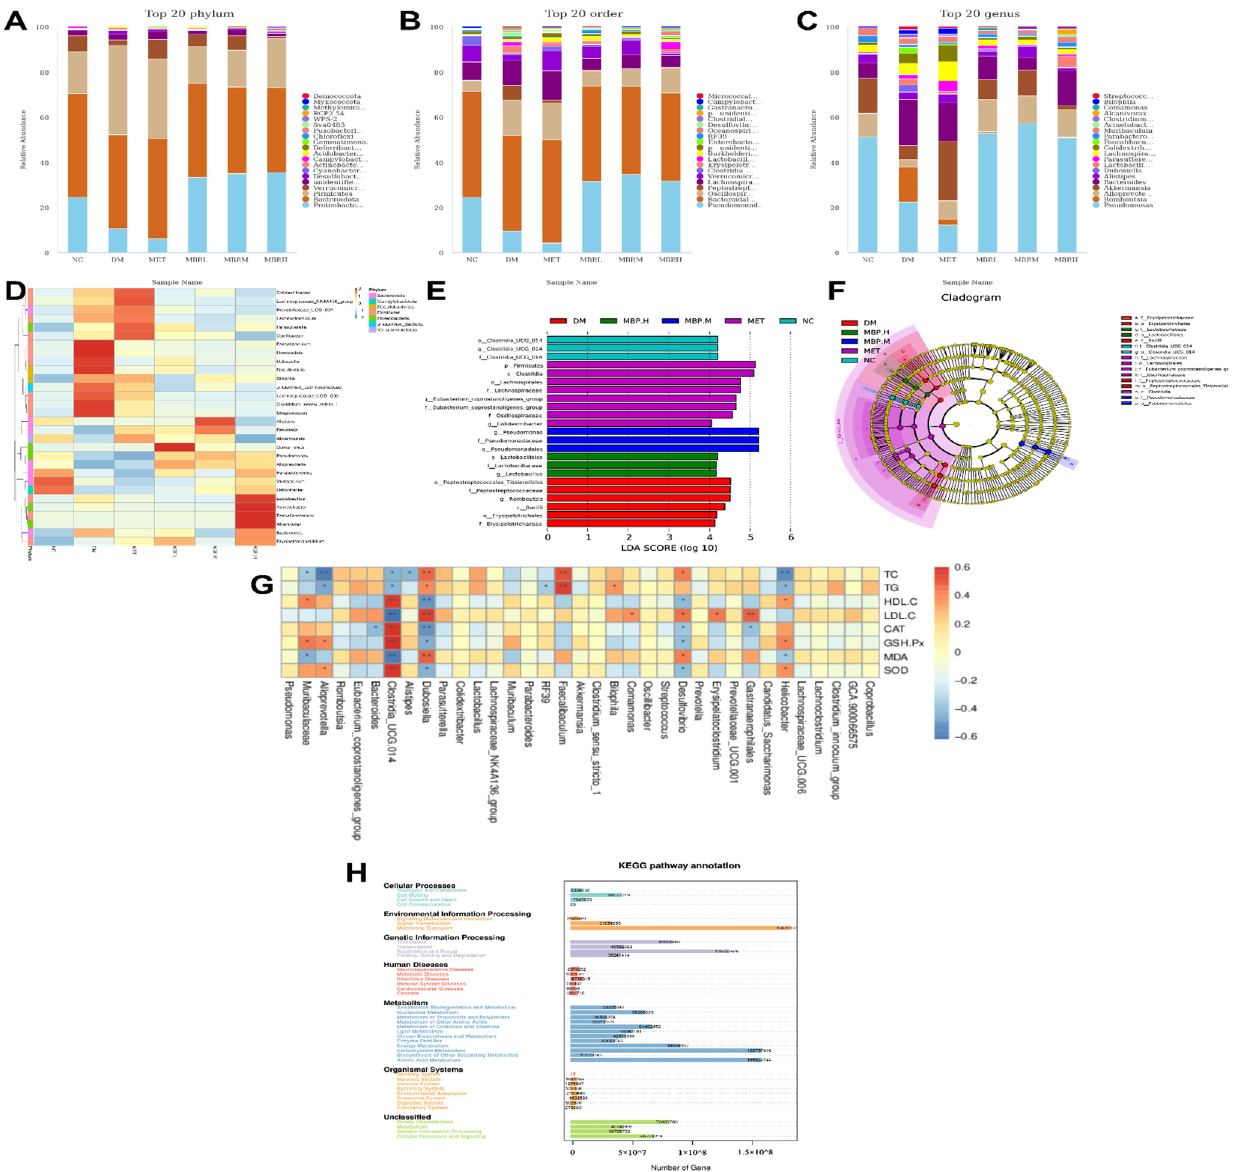
Figure 8. Relative abundance of microbiota at the levels of phylum ( A ), order ( B ), and genus ( C ). Heatmap analysis of fecal microbiota at genus level ( D ). Histogram of LDA effects of biomarker species ( E ). The taxonomic diagrams obtained from LEfSe analysis ( F ). Spearman correlation ( G ) and KEGG analysis of relative abundance of metabolic pathways ( H ).